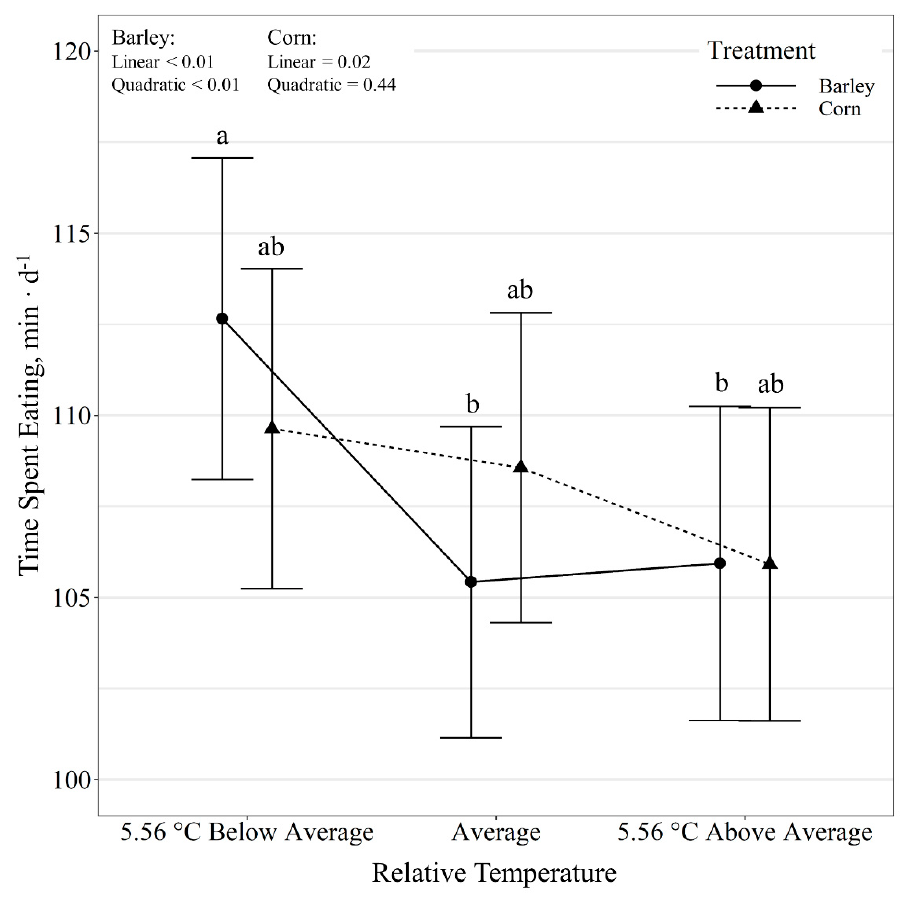
Figure 3. Influence of relative temperature change × diet ( p < 0.01) on time spent eating (expressed as min d − 1 ) by beef steers consuming either barley or corn-based feedlot diets at the Northern Agricultural Research Center, Havre, MT, USA. Data points without a common letter differ ( p < 0.05).